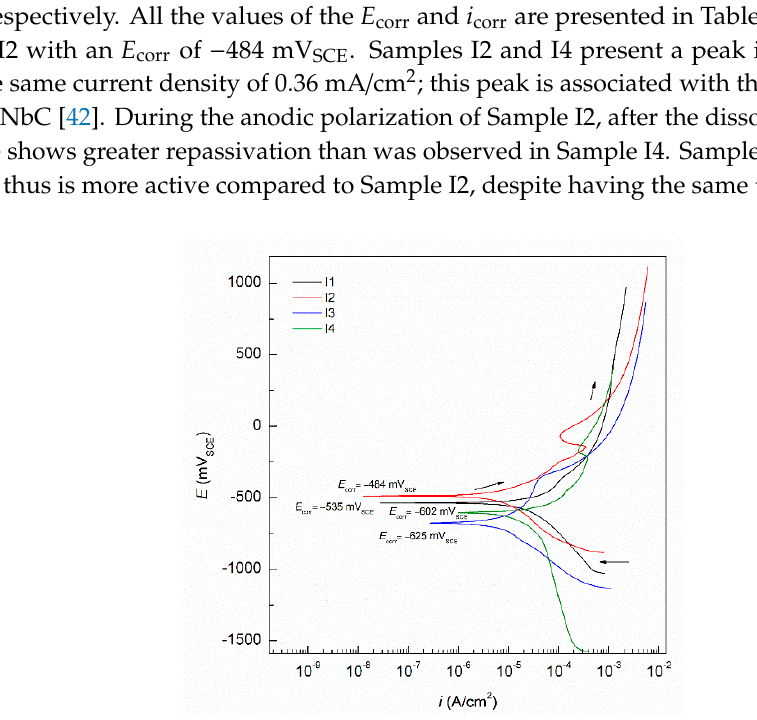
Figure 1. Cyclic potentiodynamic polarization (CPP) curves of each sample in 3.5 wt.% NaCl. Table 3. E corr and i corr values from the cyclic potentiodinamic polarization (CPP) curves of each sample.